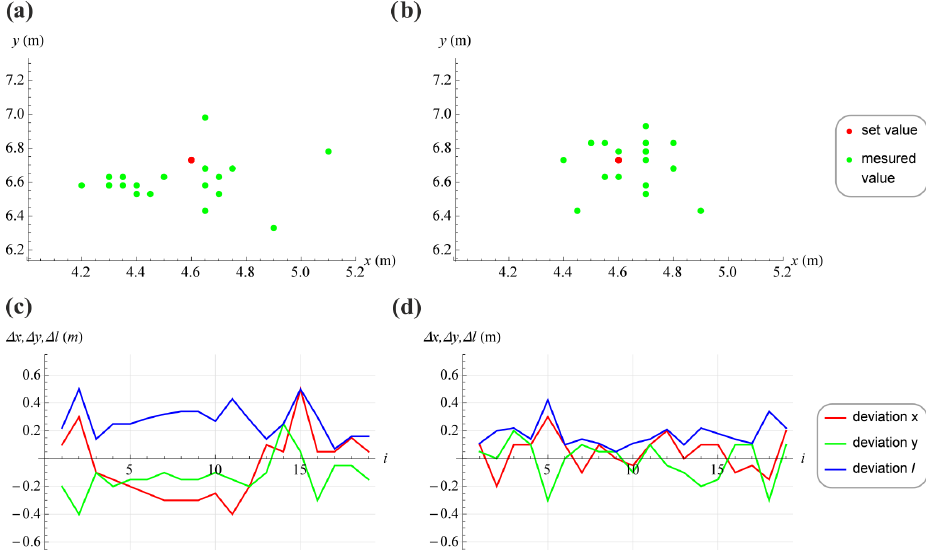
Figure 11. Accuracy measurement of point 4. ( a ) Green points represent measured positions when the robot stops. The red point is an aim point. In this experiment, the robot had the vision system turned off. ( b ) The robot had the vision system turned on. ( c ) Deviations from the aim point in x and y , where the vision system was off. ( d ) Deviations from the point where the vision system was on.